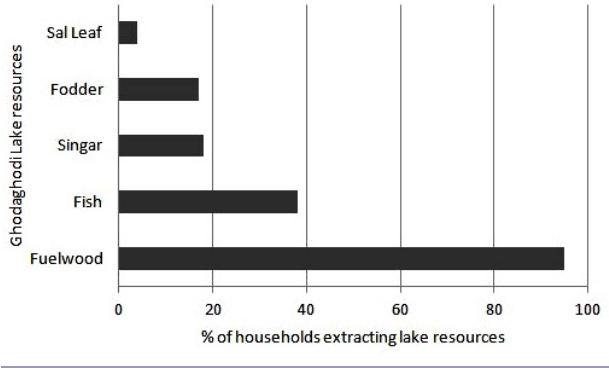
Fig. 2. Percentage of households extracting various resources from Ghodaghodi Lake complex, Nepal.